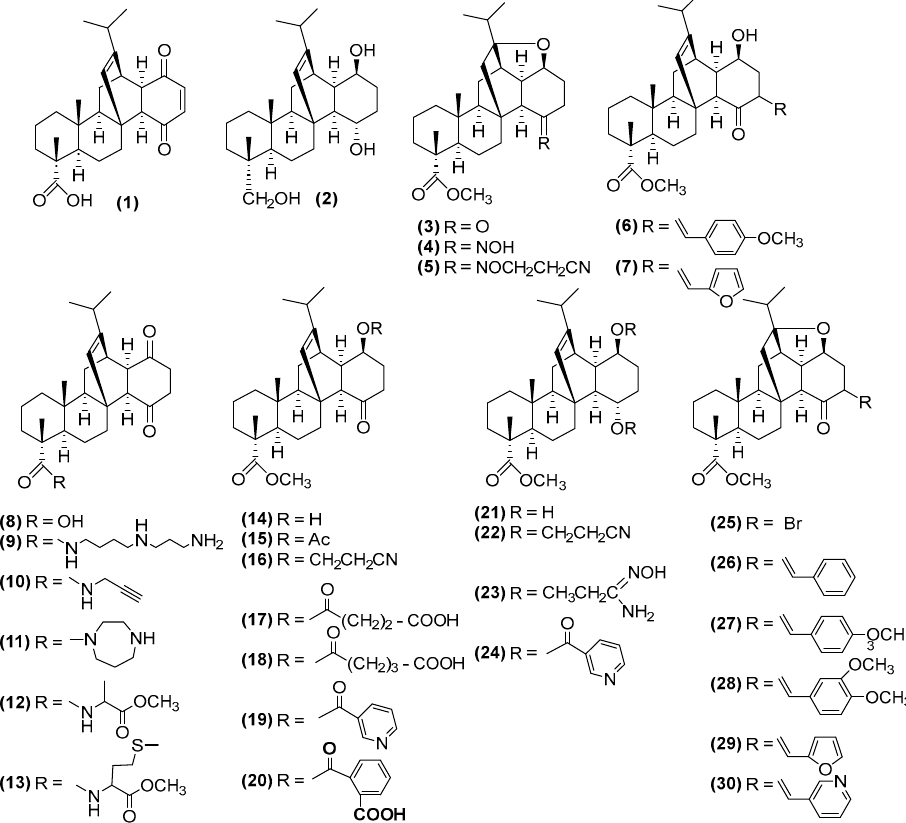
Figure 2. Structures of quinopimaric acid 1 and its analogs 2 – 30 , modified at position C-1, C-3, C-4, and C-20.